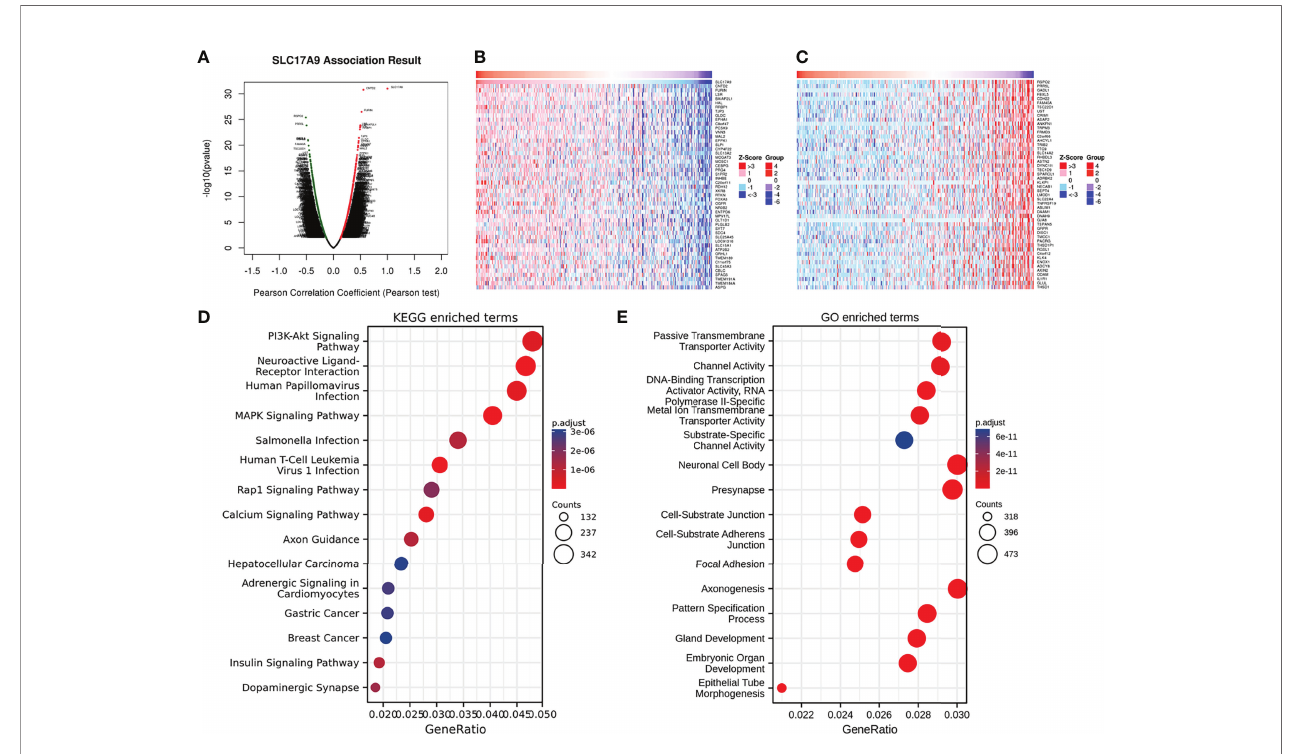
FIGURE 2 | Enrichment analysis of SLC17A9 gene co-expression network in LIHC. (A) The volcano map showed co-expression genes associated with SLC17A9 expression in the TCGA LIHC data set. (B) Heatmaps showed the top 50 co-expression genes positively correlated with SLC17A9 expression in the LIHC. (C) Heatmaps showed the top 50 co-expression genes negatively correlated with SLC17A9 expression in the LIHC. (D) Enrichment of Gene Ontology (GO) SLC17A9 co-expression genes. (E) Enrichment of Kyoto Encyclopedia of Genes and Genomes (KEGG) terms for SLC17A9 co-expression